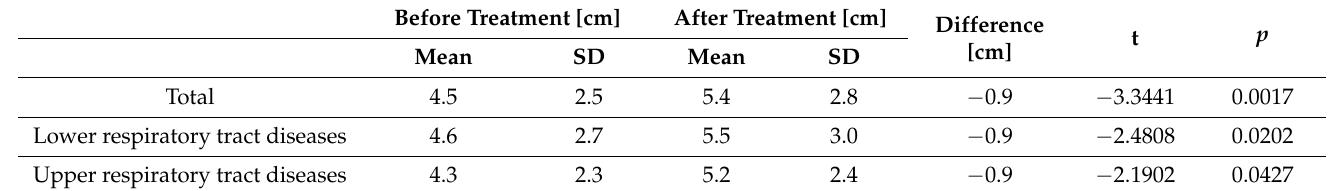
Table 3. Chest mobility before and after pulmonary rehabilitation programme combined with endurance and strength training in the underground environment.